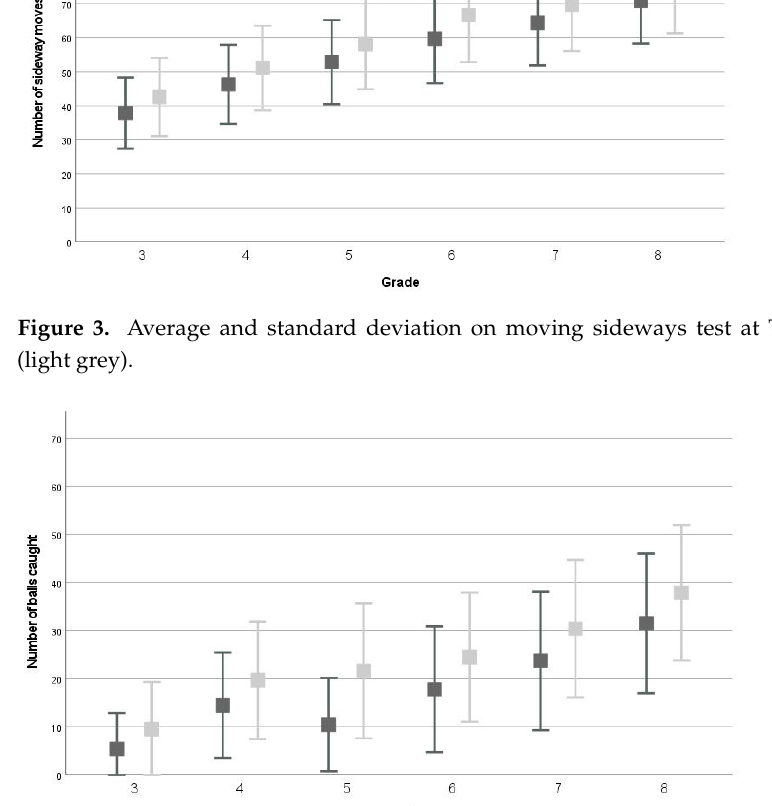
Figure 4. Average and standard deviation on eye hand coordination test at T0 (dark grey) and T1 (light grey).